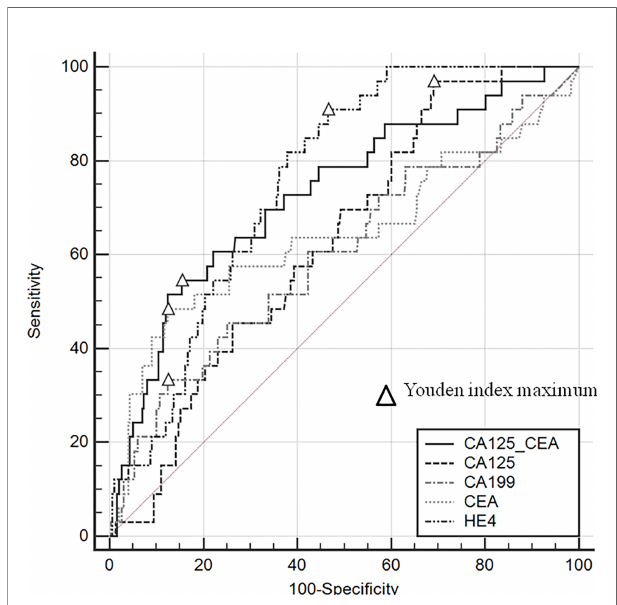
FIGURE 2 | The ROC curves of different tumor